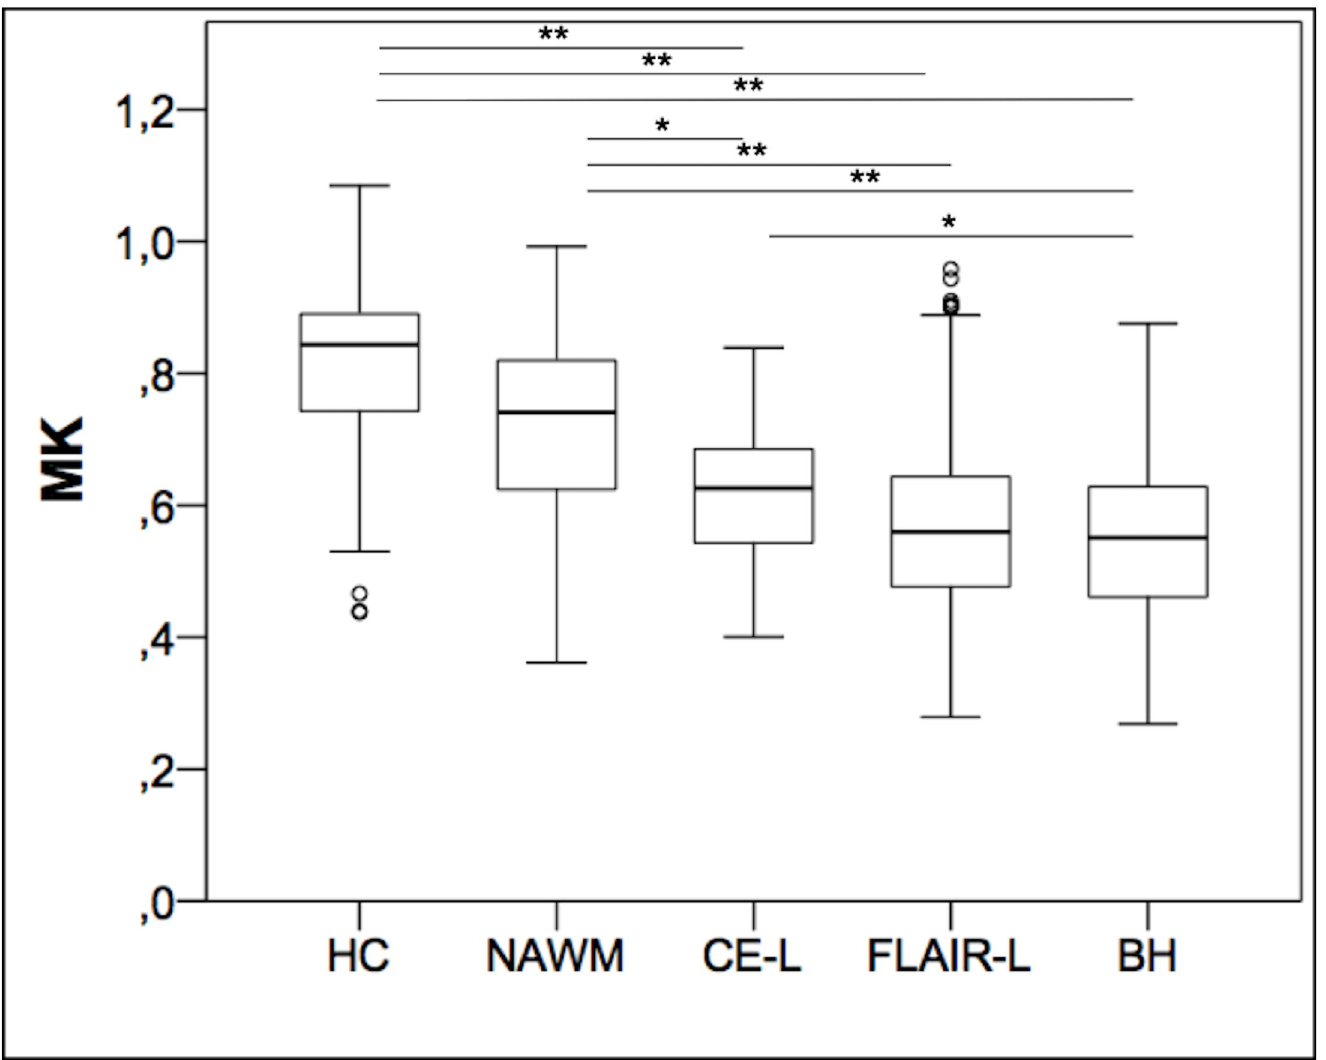
Fig 3. Distribution of mean kurtosis (MK) within the different lesion categories. Boxplots of MK in the white matter of healthy controls (HC), normal appearing white matter (NAWM) of MS patients, contrast-enhancing lesions (CE-L), FLAIR lesions (FLAIR-L) and black holes (BH). � = p < 0.05, �� = p < 0.001.